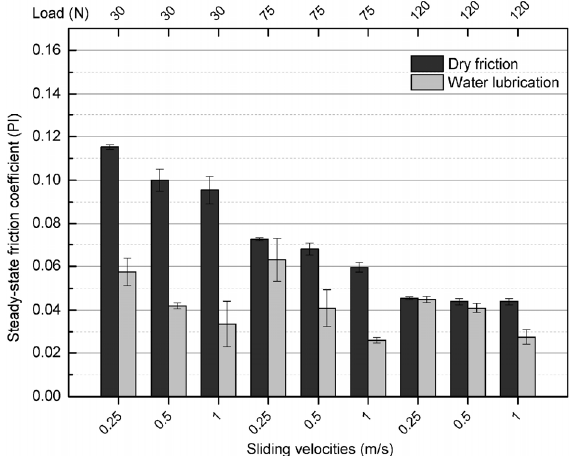
Fig. 6 The steady-state friction coefficients of PI–Si 3 N 4 tribopair at dry-friction and water-lubricated conditions under different loads and sliding velocities.